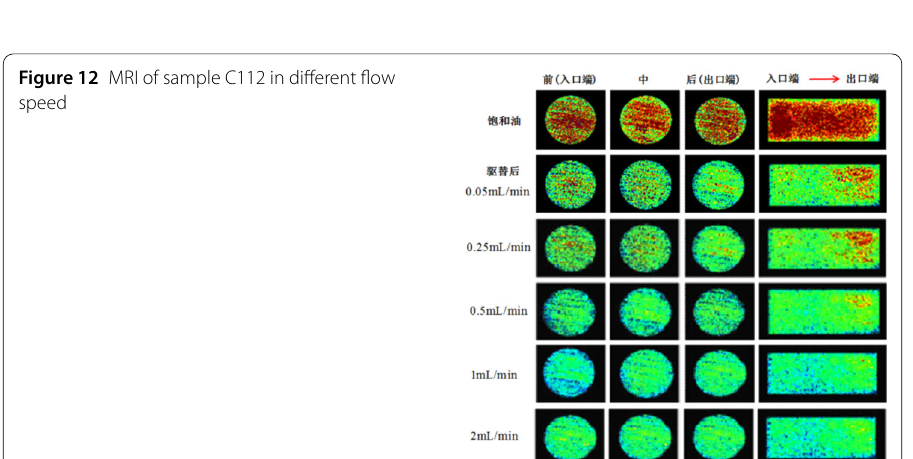
Figure 12 MRI of sample C112 in different flow speed